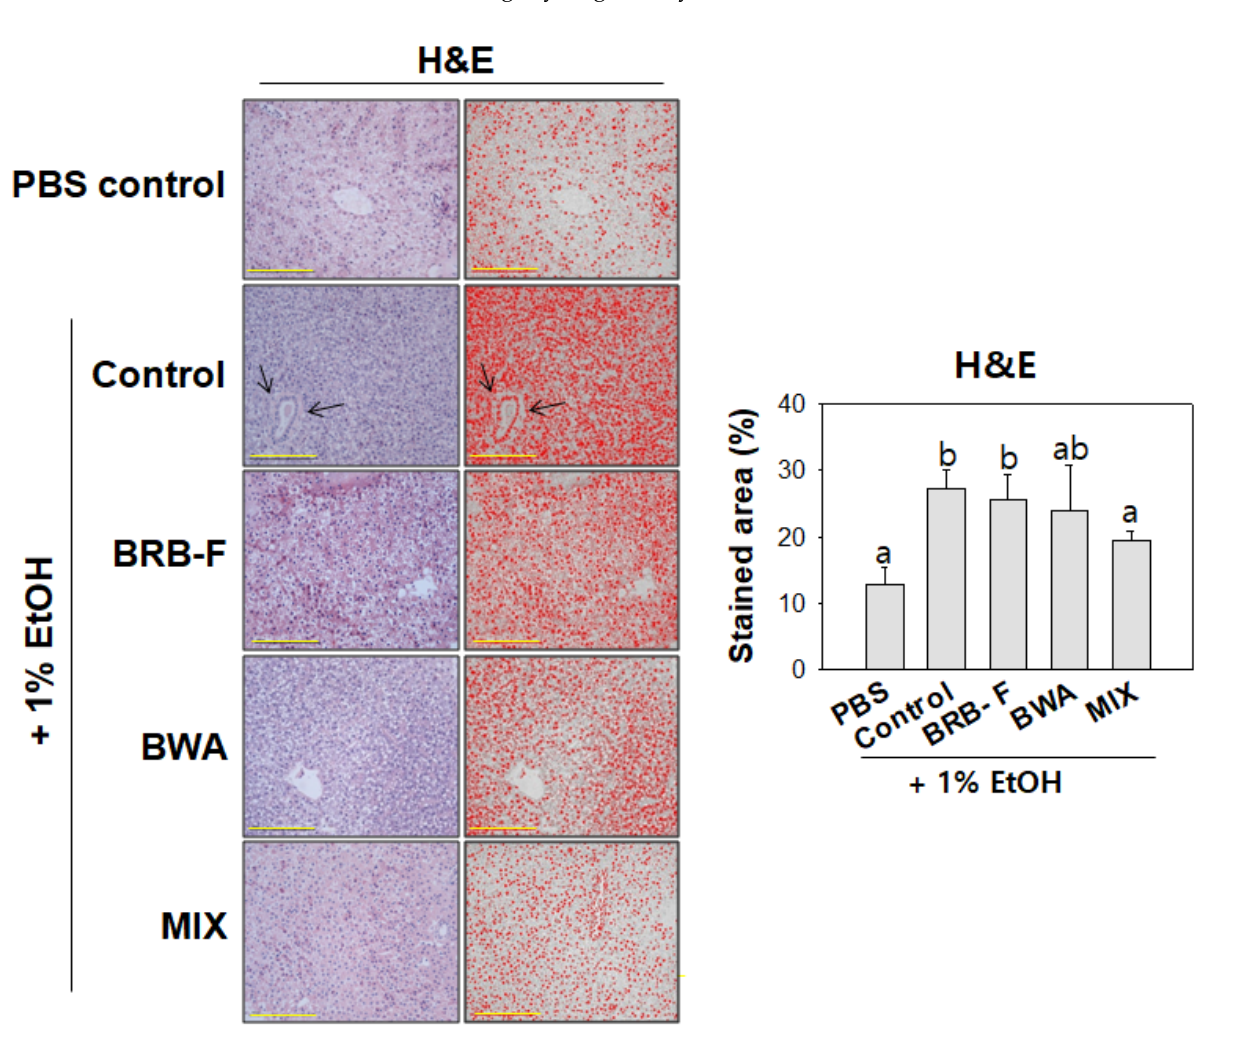
Figure 3. Effect of BRB-F, BWA, and MIX in alcohol liver injury zebrafish for 10 days on the hepatic morphology (400×, Scale bar: 100 µm). Data are the mean ± SEM; a,b mean values with different superscript letters are significantly different among the groups ( p < 0.05); PBS, zebrafish exposed to 1% PBS, n = 20; EtOH, zebrafish exposed to 1% EtOH, n = 20; BRB-F, EtOH fed 10% black rice bran, n = 20; BWA, EtOH fed 10% beeswax alcohol, n = 20; MIX, EtOH fed a mixture of BWA and BRB-F (1:6, w / w ), n = 20. H&E-stained transverse section of the liver; representative photomicrographs of the liver are shown at 400× magnification; black arrows indicate alcoholic foamy degeneration; scale bar indicates 100 µm.